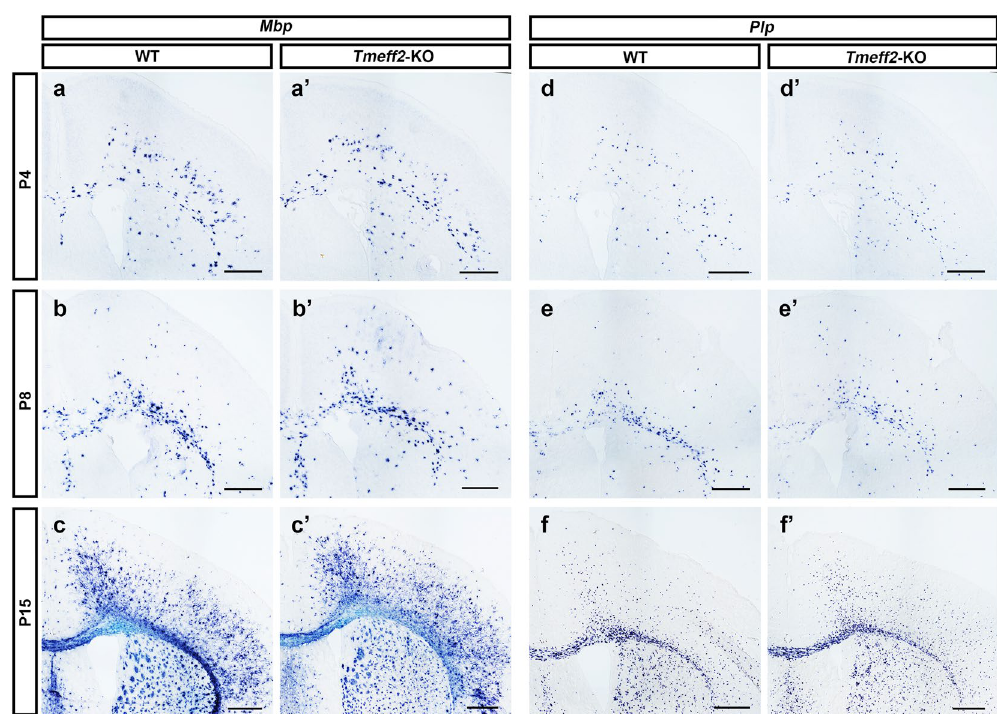
Figure 7. Normal differentiation of OLs in postnatal Tmeff2 -KO mutant forebrains. ( a–f,a’–f’ ) Brain sections of wild type ( a–f ) and Tmeff2 -KO mutants ( a’–f’ ) were subjected to ISH with Mbp ( a–c,a’–c’ ) and Plp ( e–f,e’–f’ ) riboprobe at P4, P8 and P15 stages. Bar, 500 μ